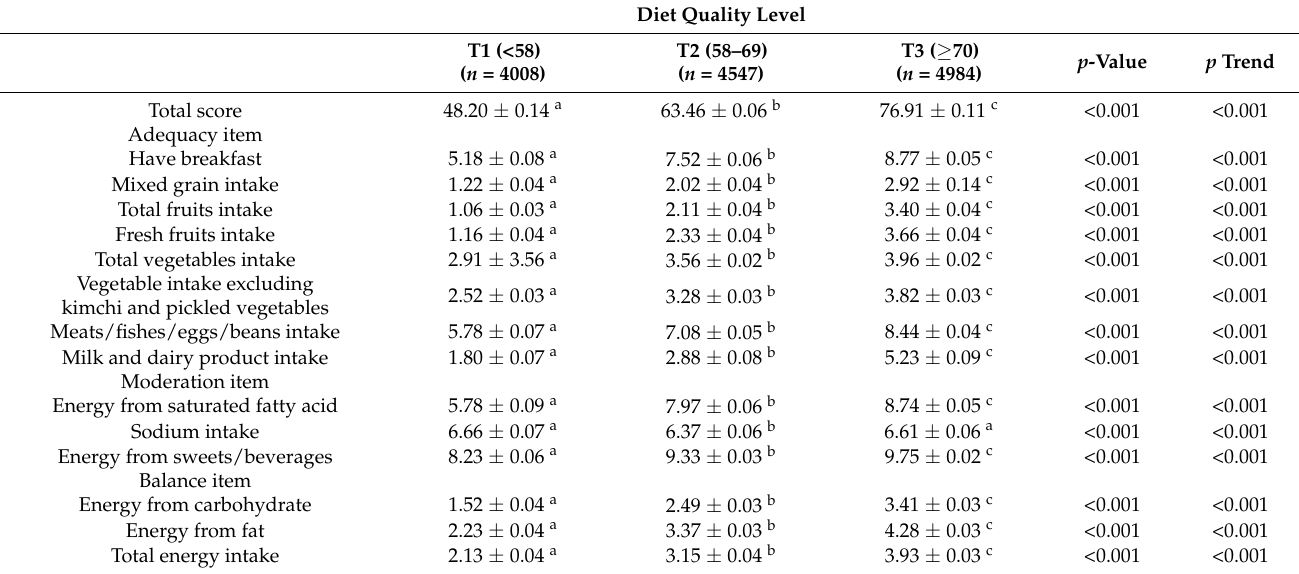
Table 4. Scores of Korean healthy eating index of subjects according to diet quality level.